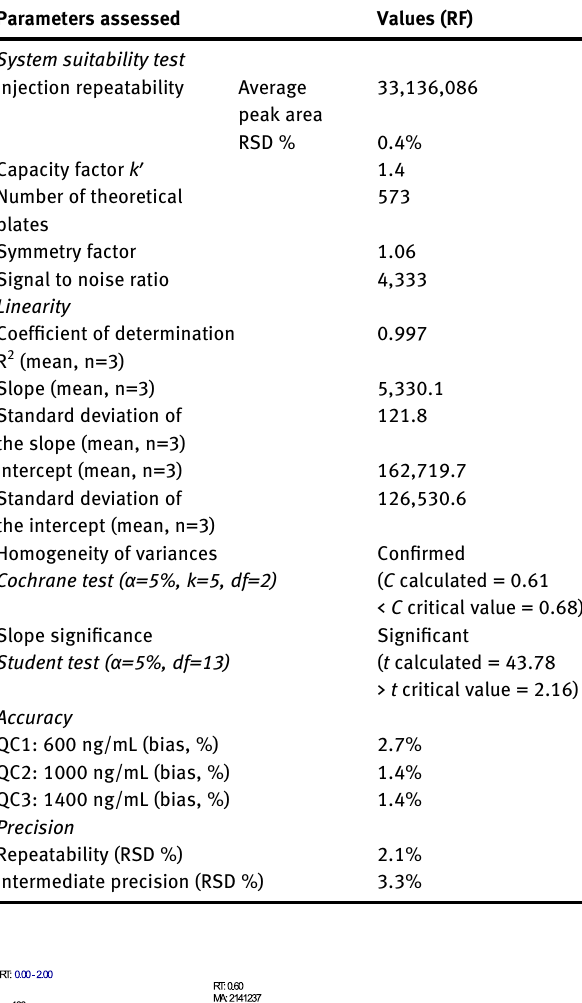
Table  : Evolution of relative midazolam content (%) over time, expressed as  % CI of the mean (n=  ,  units per